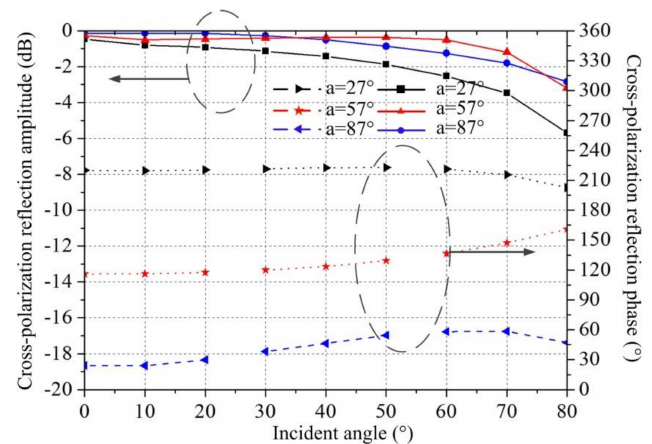
Figure 7. Simulated cross-polarization reflection amplitude and phase of a reflect surface unit cell under different incident